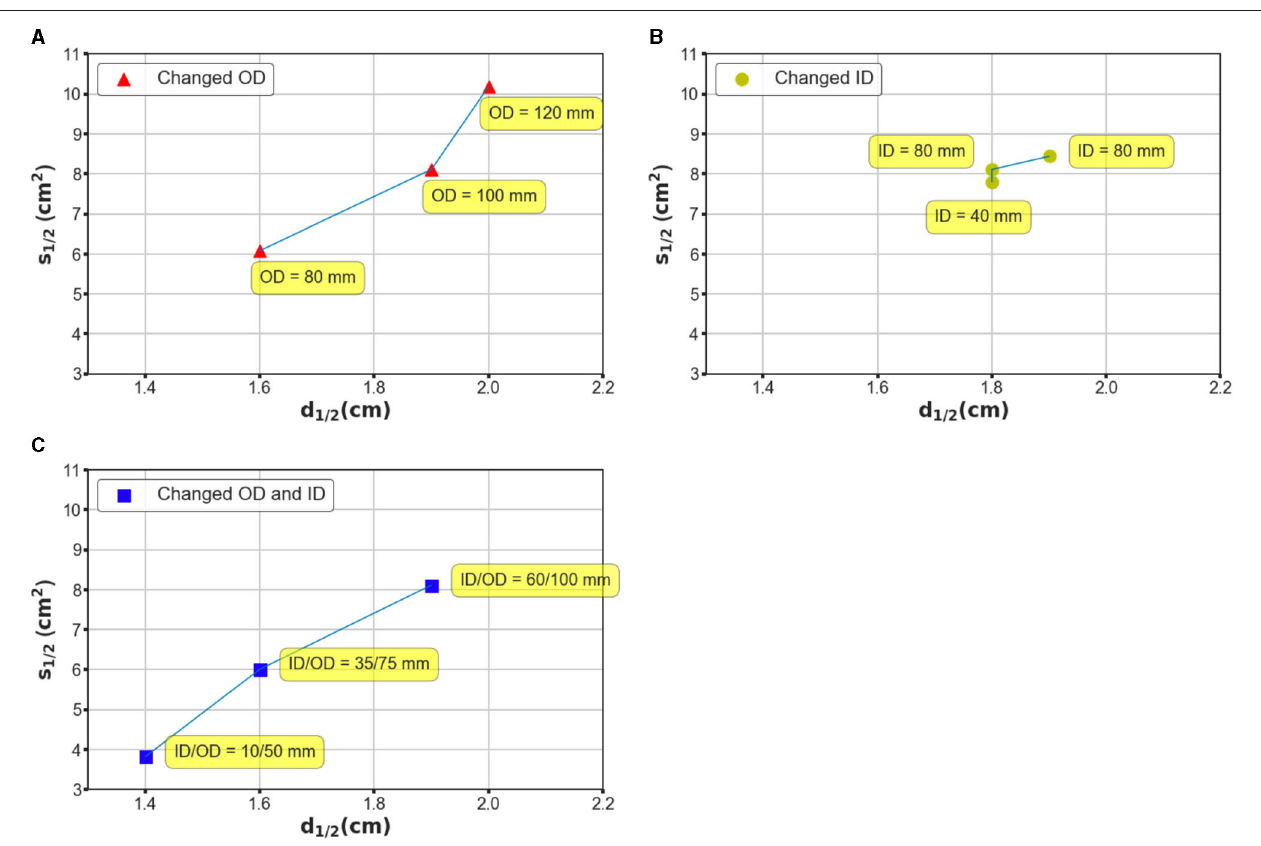
FIGURE 5 | Investigation of mechanism based on which the coil geometry can affect the performance of the stimulation. (A) The OD was designated as 80, 100, and 120 mm, while the ID was maintained at 80 mm. (B) The ID was designated as 80, 60, and 40 mm, while the OD was maintained at 100 mm. (C) The OD and ID were changed simultaneously such that the interval remained constant. The OD–ID values are 10–50, 35–75, and 60–100 mm,